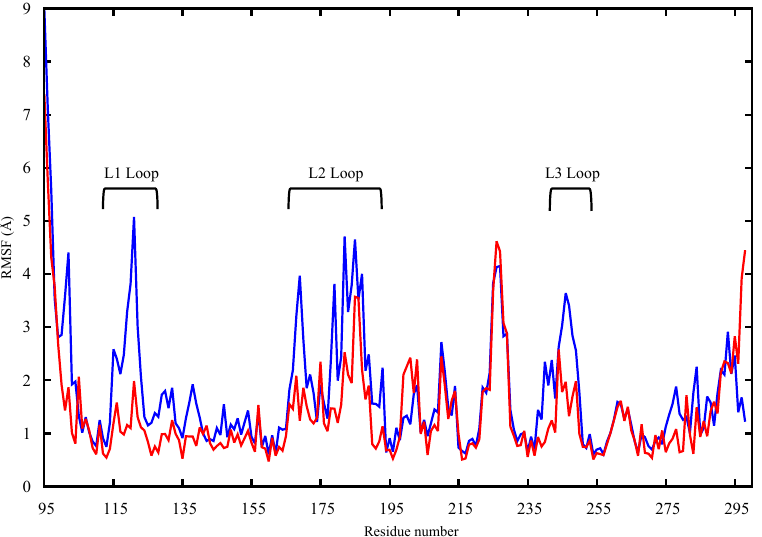
Figure 2. The RMSF plot of the backbone heavy atoms of the apo monomers of wt-p53 (blue) and G245S-mp53 (red). The loops L1, L2 and L3 are indicated.